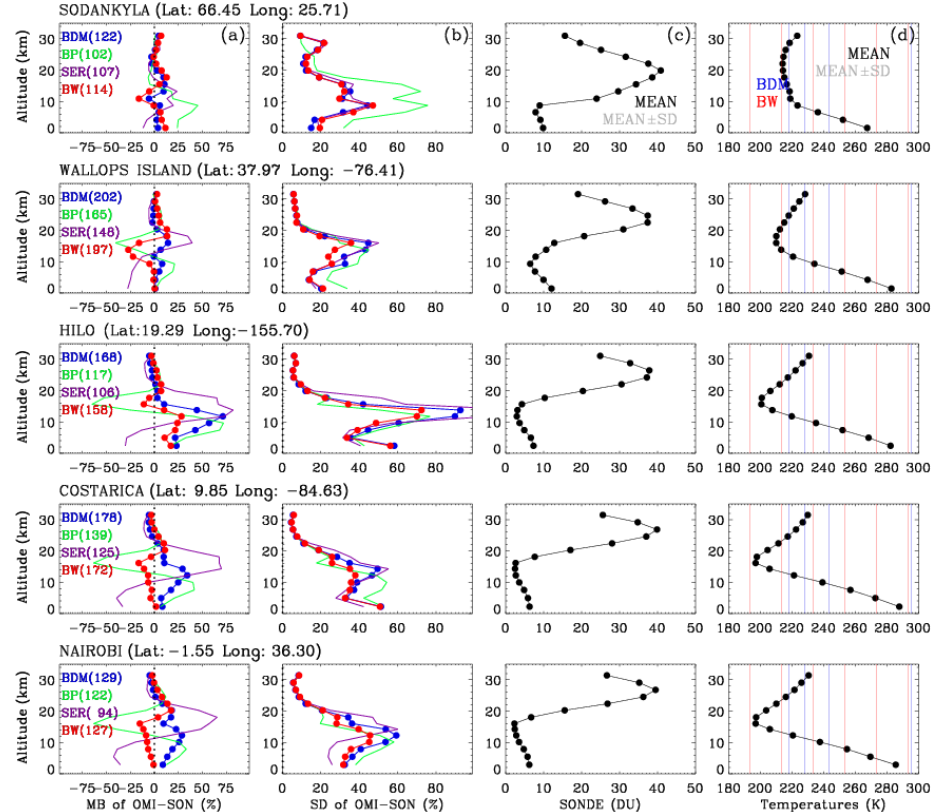
Figure 9. (a) Mean biases of relative differences between OMI and ozonesonde ozone profiles at five stations arranged with decreasing latitude when four different cross-sections are applied to OMI retrievals, with (b) the corresponding standard deviations. (c) Ozonesonde and (d) temperatures (black circles) averaged from individual profiles (gray). The numbers after the four cross-sections in the legends show the number of successful retrievals. Vertical blue and red colors in (d) represent the temperatures used to derive the quadratic coefficients from BDM and BW measurements,